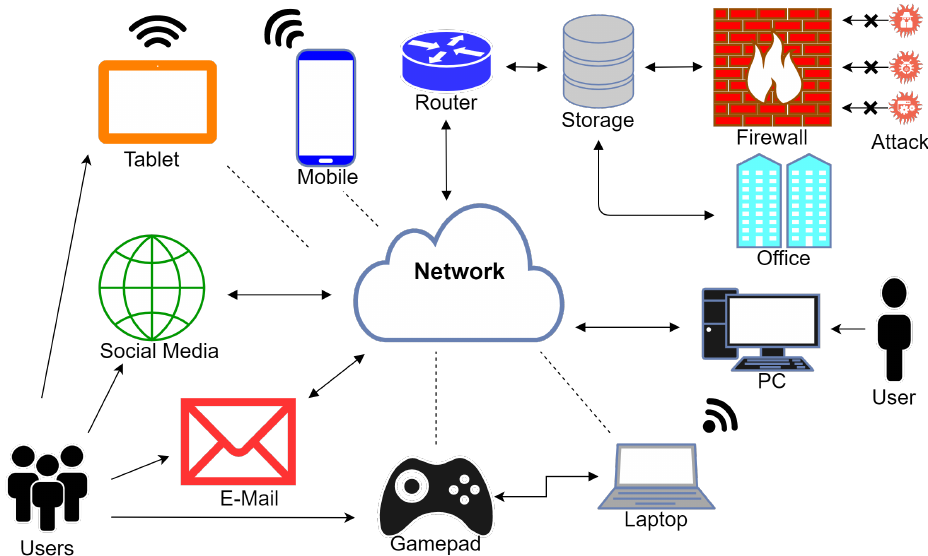
Figure 1. General representation of an IoT